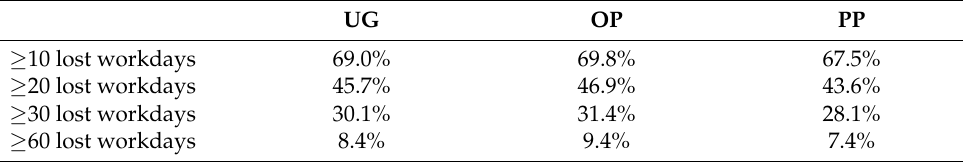
Table 3. Probability of an accident involving different lost